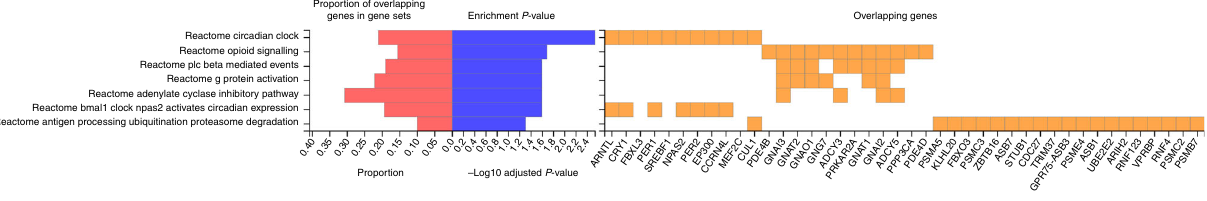
Fig. 2 Reactome gene sets overlapping Chronotype genes. Chronotype genes were identi fi ed using positional and eQTL mapping in FUMA ’ s GENE2FUNC process. Note that these results may differ to those produced by MAGMA